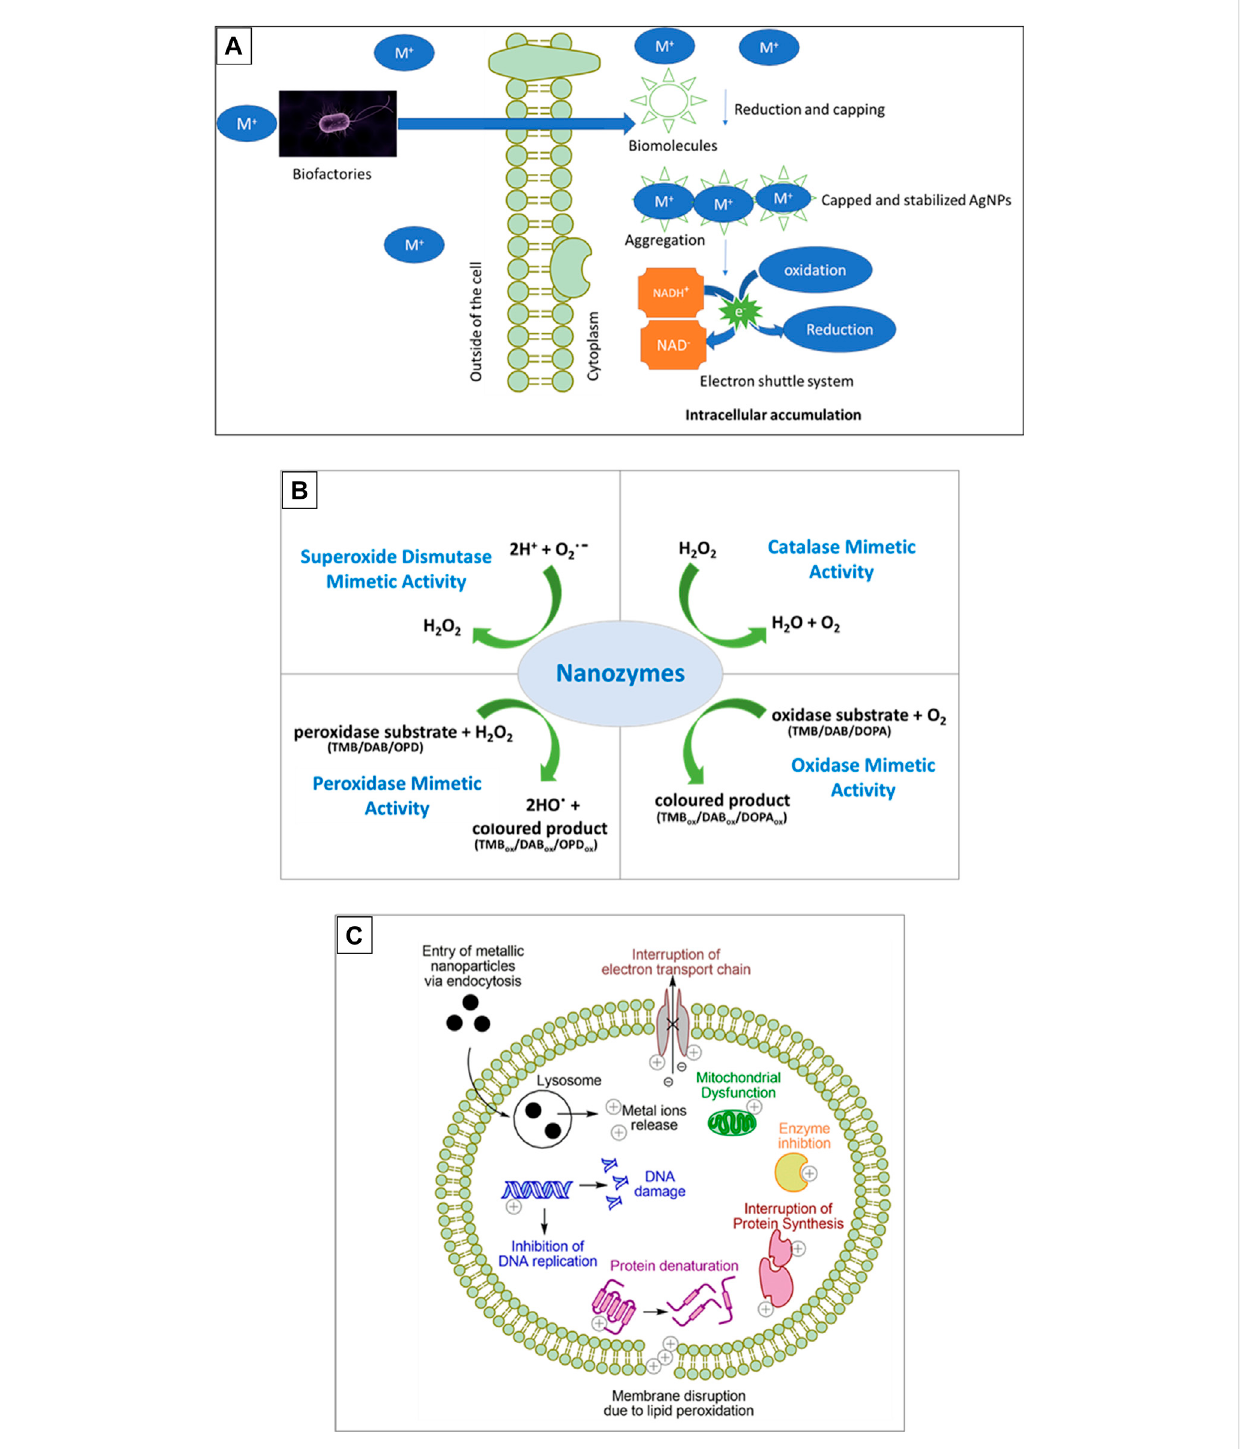
FIGURE 1 Synthesis, enzyme function and toxicity of metallic nanoparticles. (A) Is a schematic representation of biosynthesis of metal nanoparticles by microorganisms, (B) depicts the enzyme mimetic activity of biogenic nanoparticles and (C) shows the mechanisms of nanoparticle toxicity. Substrates used are 3, 3 ′ , 5, 5 ′ -Tetramethylbenzidine (TMB), 3, 3 ′ -Diaminobenzidine (DAB), o-phenylenediamine (OPD), or 3,4-dihydroxyphenylalanine